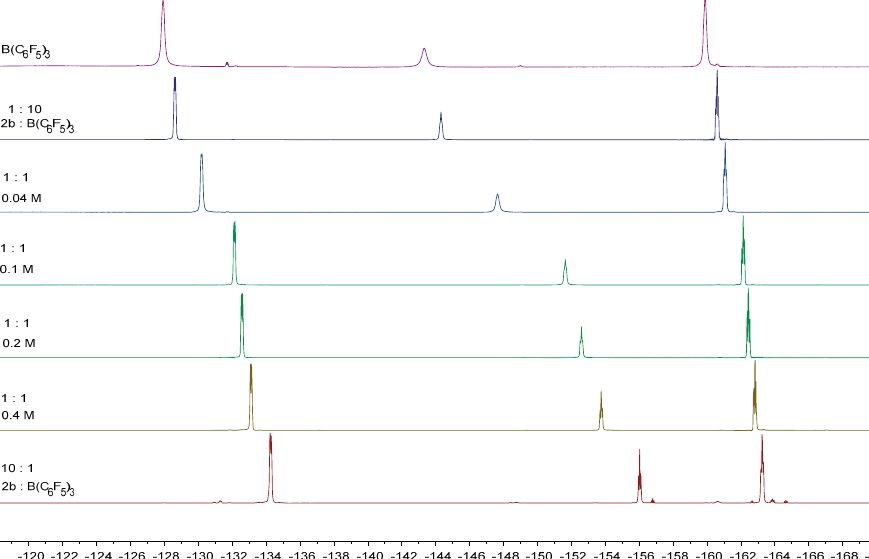
Figure 1. 19 F stacked spectra of the reactions of 1b with B(C 6 F 5 ) 3